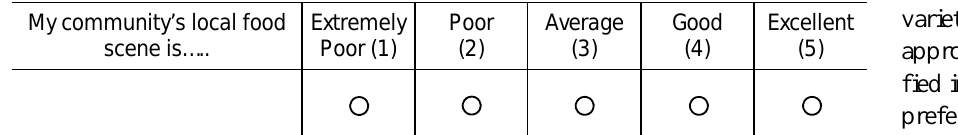
Figure 2. Overall LFS Rating Question Rate the vitality of your local food scene. Vitality is defined as ‘the strength and activeness of the local food scene.’ My community’s local food scene